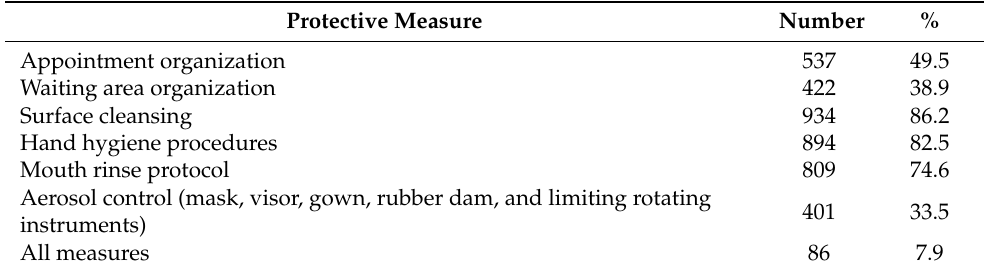
Table 2. Implementation (number of dentists, percentage) of the different parts of the protective measures protocol by dentists based on aggregated variables.